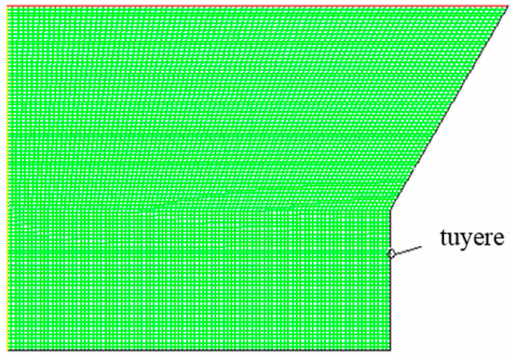
Figure 1. Schematic diagram of the computational domain for the tuyere zone.